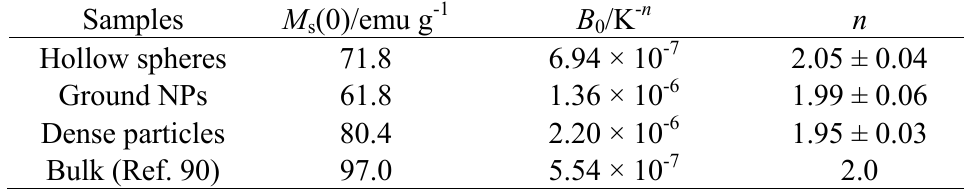
Table 2. Saturation magnetization M magnetite hollow spheres, dense particles, ground NPs, and bulk magnetite.